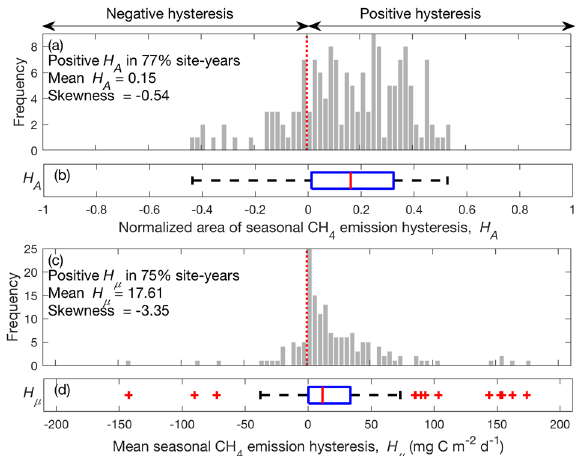
Fig. 2 Predominantly positive seasonal CH 4 emission hysteresis inferred from ecosystem-scale measurements across the globe, i.e., CH 4 emissions are generally higher later in the frost-free season at the same temperature. The distribution of normalized area of seasonal CH 4 emission hysteresis ( H A ; a , b ) and mean seasonal CH 4 emission hysteresis ( H μ ; c , d ) to air temperature among site-years derived from the FLUXNET-CH 4 database. Positive seasonal CH 4 emission hysteresis indicates higher CH 4 emissions later in the frost-free season at the same temperature (e.g., Fig. 1d – f). Red dashed lines represent no hysteresis. The corresponding boxplot of site-year speci fi c H A ( b ) and H μ ( d ) derived from the FLUXNET- CH 4 database. The red central mark, and the bottom and top edges of the blue box indicate the median, and the 25 th and 75 th percentiles, respectively. The black whiskers extend to the most extreme data points not considered outliers denoted in red plus